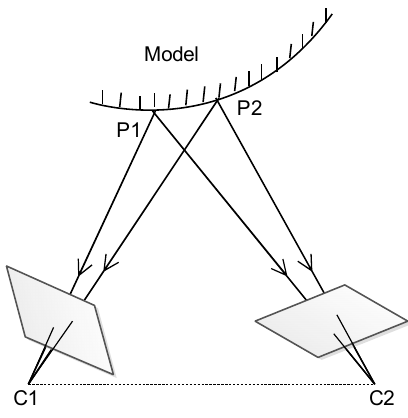
Figure 12. Measurement principle of the video grammetric model deformation (VMD) system.